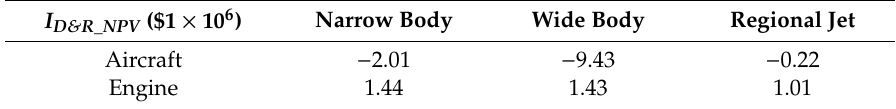
Table 7. Disposal and recycle NPV based on average aircraft value ( I D & R _ NPV ) ( n D&R = 3, i = 8%) (2014